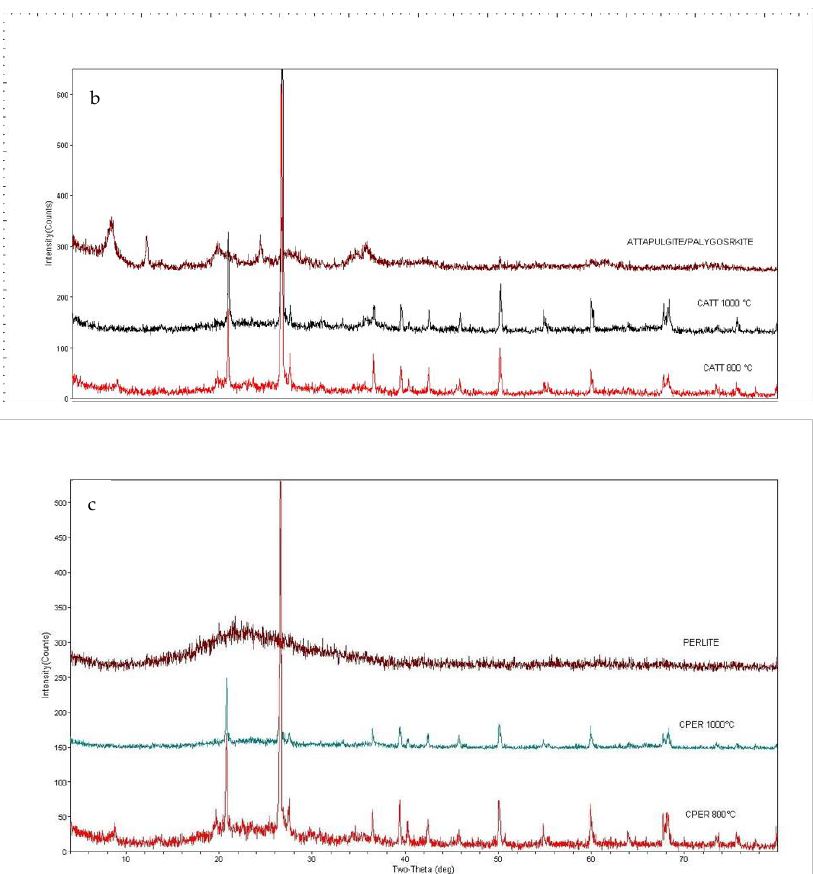
Figure 1. X-ray pattern to show the phase evolution of ( a ) clay, ( b ) clay with attapulgite and ( c ) clay with perlite when firing temperature is increased. Qtz = Quartz, Kaol = Kaolinite, Mc = Microcline, Ms = Muscovite, Lz = Lizardite, Pal = Palygorskite (abbreviations from